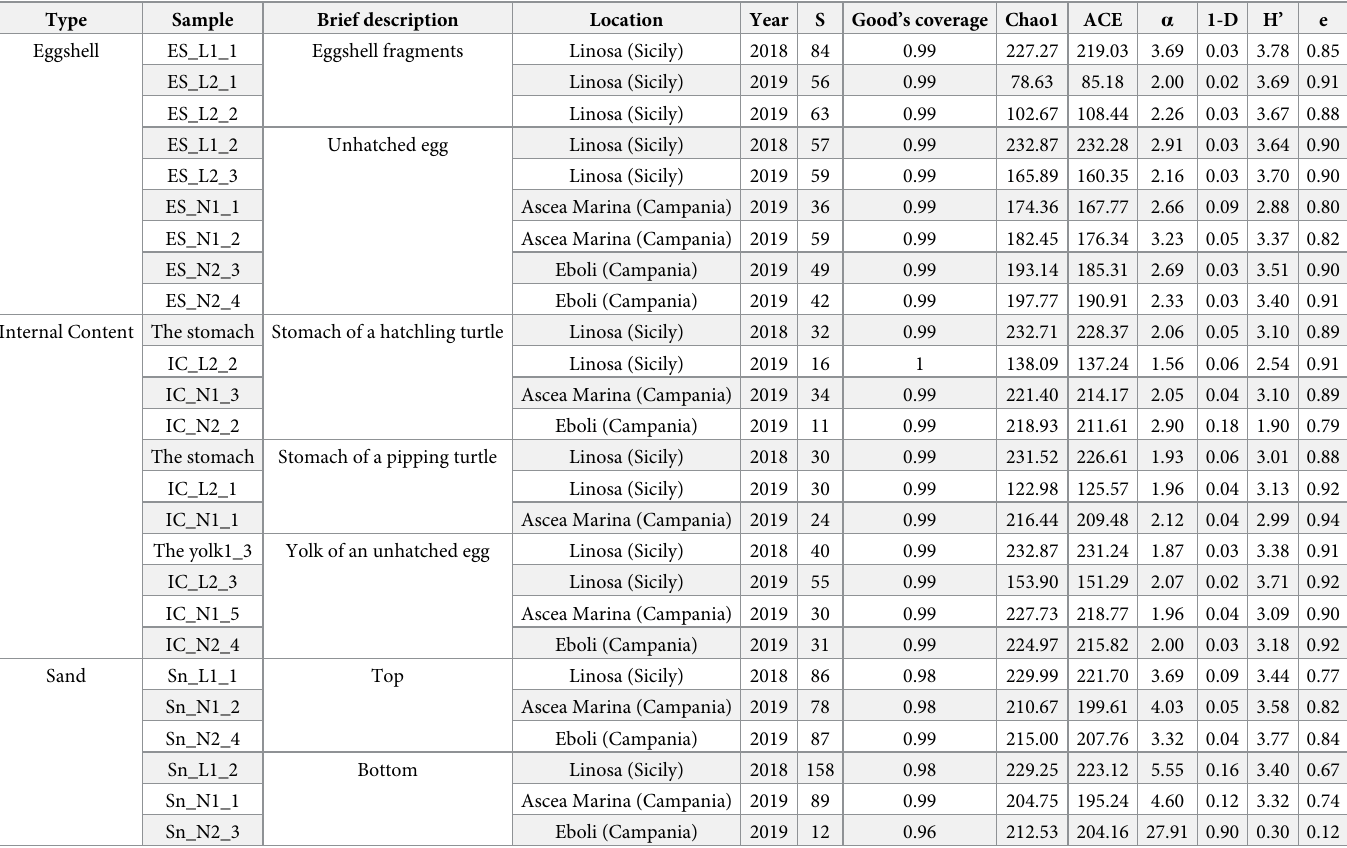
Table 1. Description and diversity indices of the samples used in this study.